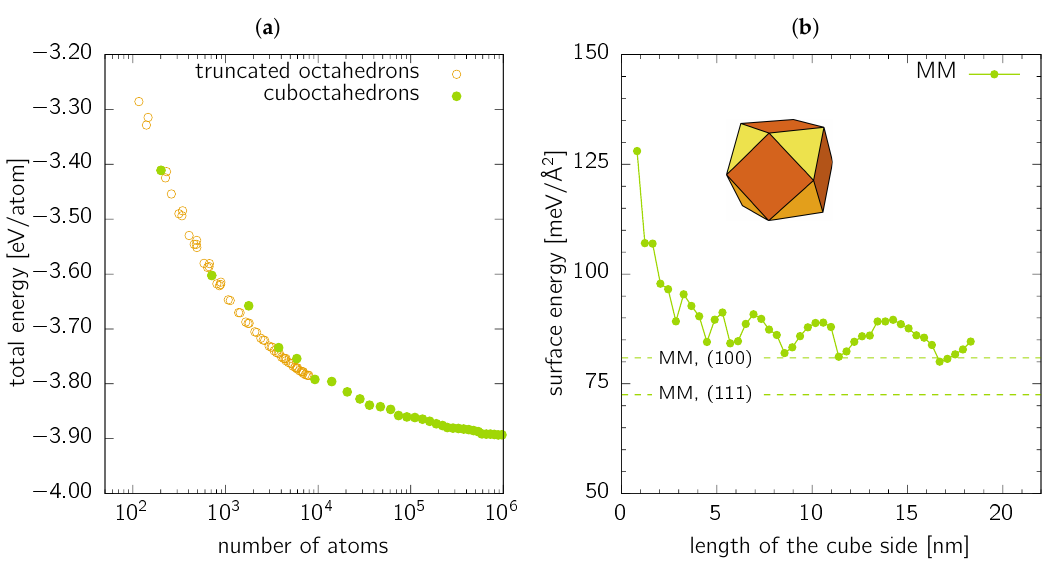
Figure 4. ( a ) Total energy per atom as a function of the nanoparticle size (in terms of number of forming atoms) for cuboctahedrons (full circles) and general truncated octahedrons (open circles). ( b ) Surface energy of cuboctahedrons calculated by MM and showed as a function of the size of “parent” cube. The dashed lines are the MM values for single-orientated ( 100 ) and ( 111 ) surfaces as listed in Table